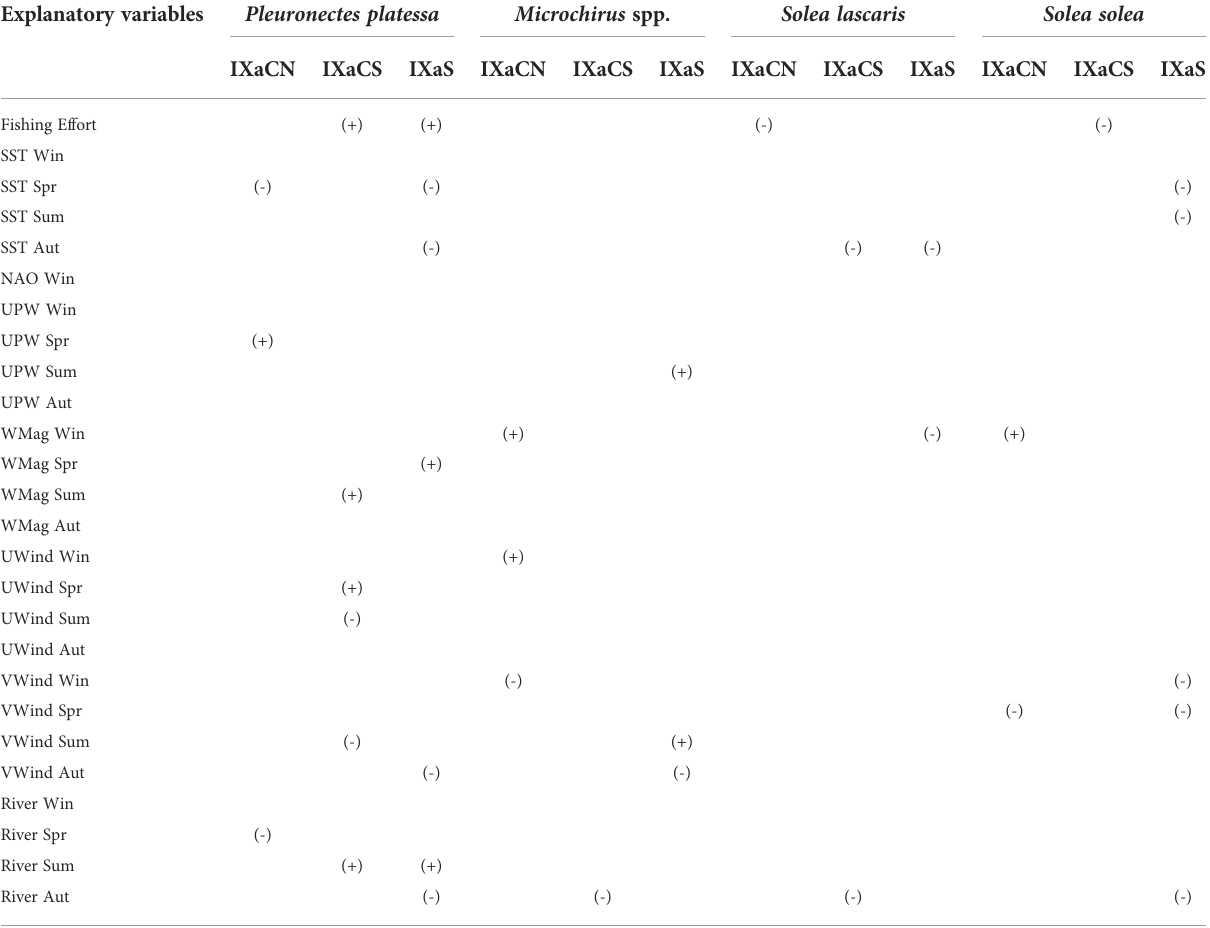
TABLE 5 Summary of results of relationships (signi fi cant in two or more time series analysis) between each fl at fi sh species (Landings per unit effort- LPUE) and explanatory variables ( fi shing effort and environmental factors) using Min/Max Autocorrelation Factor Analysis (MAFA), Dynamic Factor Analysis (DFA) and Generalised Least Squares (GLS) corresponding to the age-group II (Lag1 for Pleuronectes platessa , Microchirus spp., Solea lascaris and Solea solea ), along the Portuguese coast: Northwest (IXaCN), Southwest (IXaCS) and South (IXaS). Explanatory variables Pleuronectes platessa Microchirus